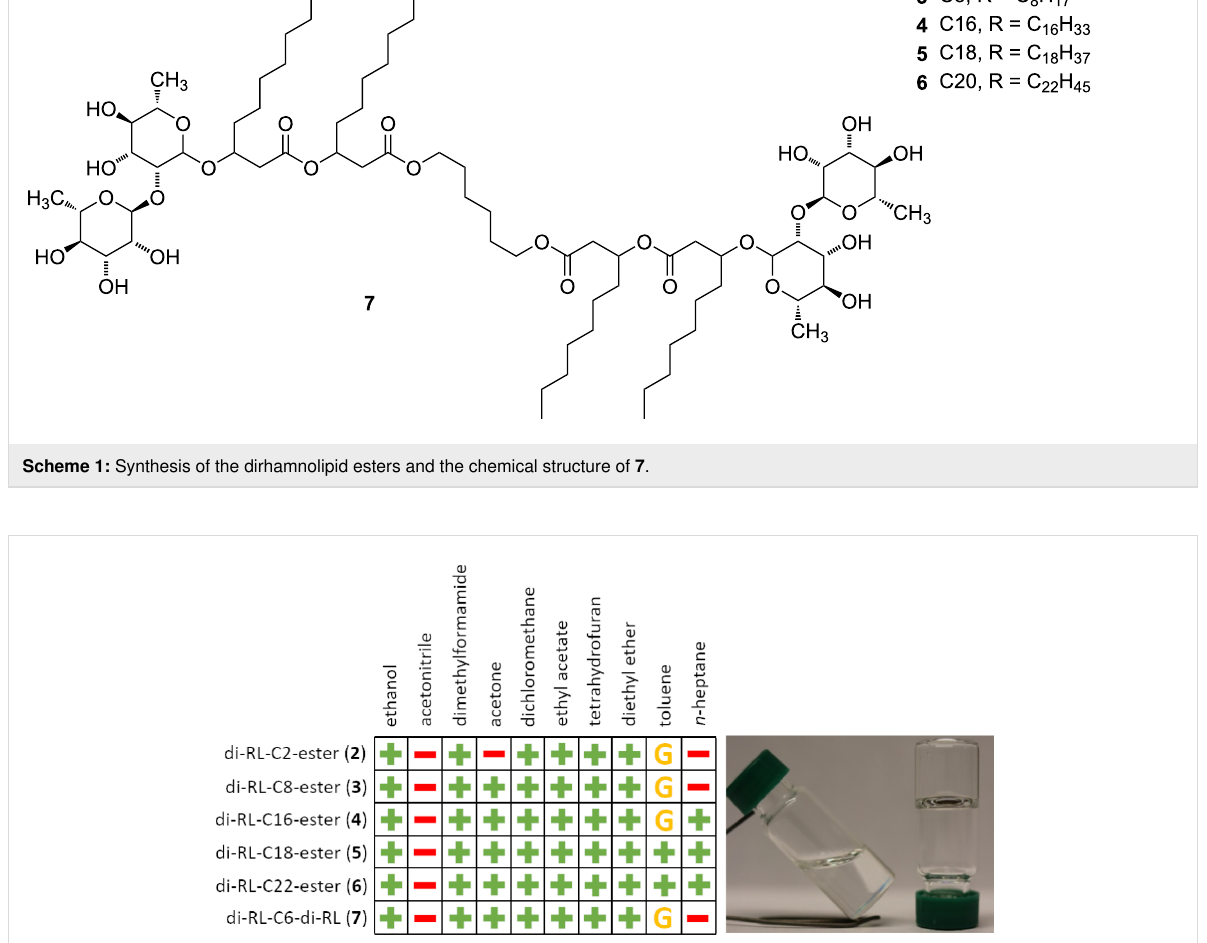
Figure 2: Solubility of the dirhamnolipid esters in various solvents (+ = soluble, − = insoluble, G = gel).